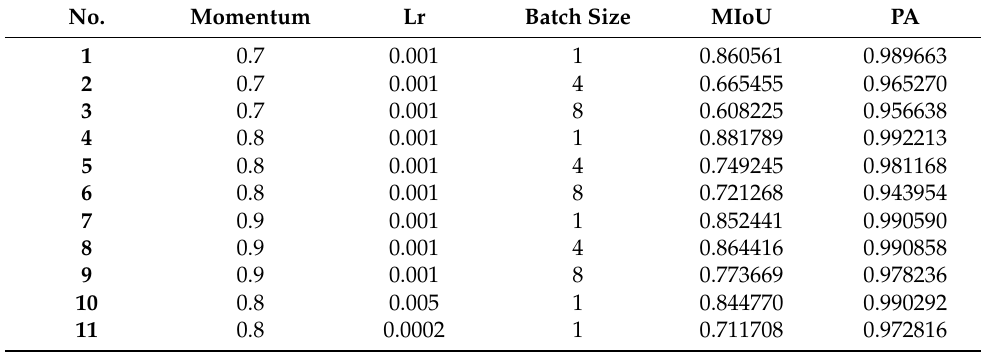
Table 6. Accuracy achieved with different parameters.